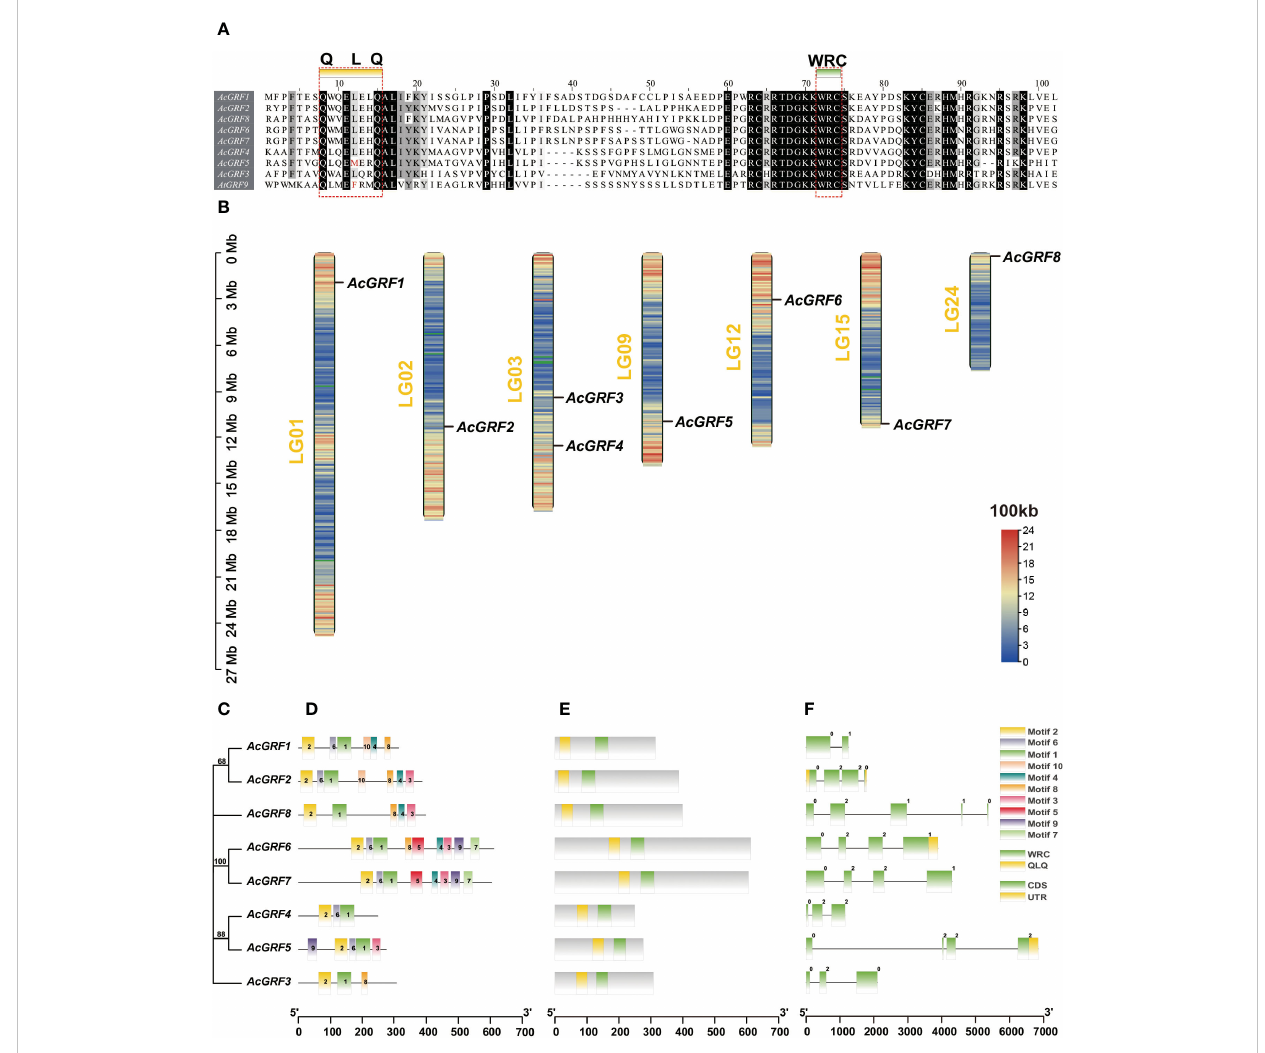
FIGURE 1 Conserved sequences, chromosomal distribution, gene structures, and motif patterns of AcGRF genes and their encoded proteins. (A) Conserved sequences in AcGRF genes. The QLQ and WRC domains are marked with a red rectangular box, and the amino acids replaced in the QLQ domain are indicated in a red font. (B) Chromosomal distribution of AcGRF genes. The sliding window size was set to 100 kb, and the color from red to blue indicates high to low gene density. Blank areas on chromosomes are genetic regions for which information on gene distribution is lacking. (C) Phylogenetic clustering of AcGRF proteins. (D) Motif patterns of AcGRF proteins. (E) Conserved domains in AcGRF proteins. (F) AcGRF gene structures. Yellow boxes indicate 5 ′ and 3 ′ UTR regions; green boxes indicate exons; black lines represent introns; and the number (0 – 2) indicates the intron